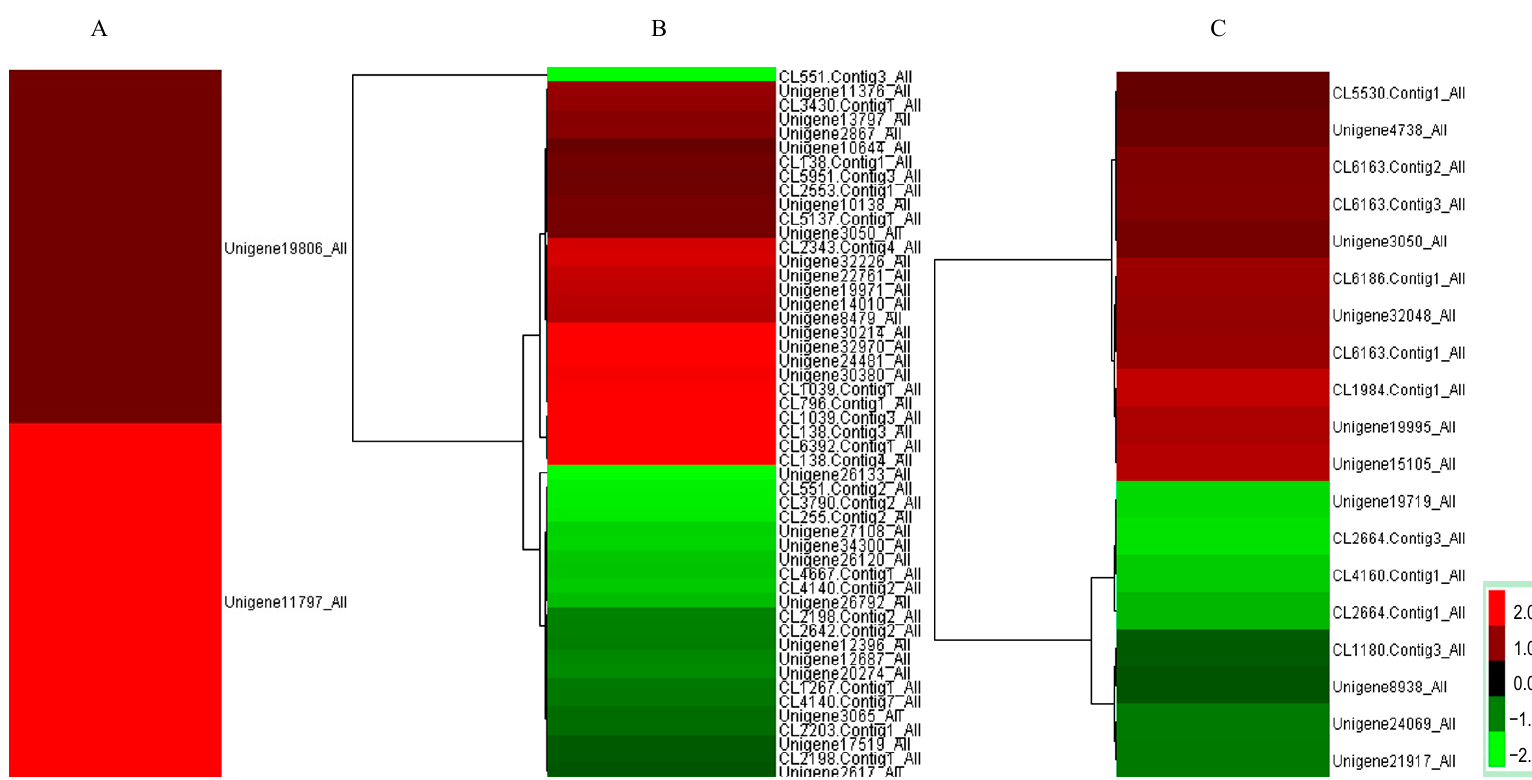
Figure 3. Clustering of differentially expressed genes. Red colors indicate up-regulation, and green colors indicate down-regulation. ( A ) Differentially expressed genes related to nitrate reductase activity; ( B ) Differentially expressed genes related to the response to organic nitrogen; ( C ) Differentially expressed genes related to nitrate transport.